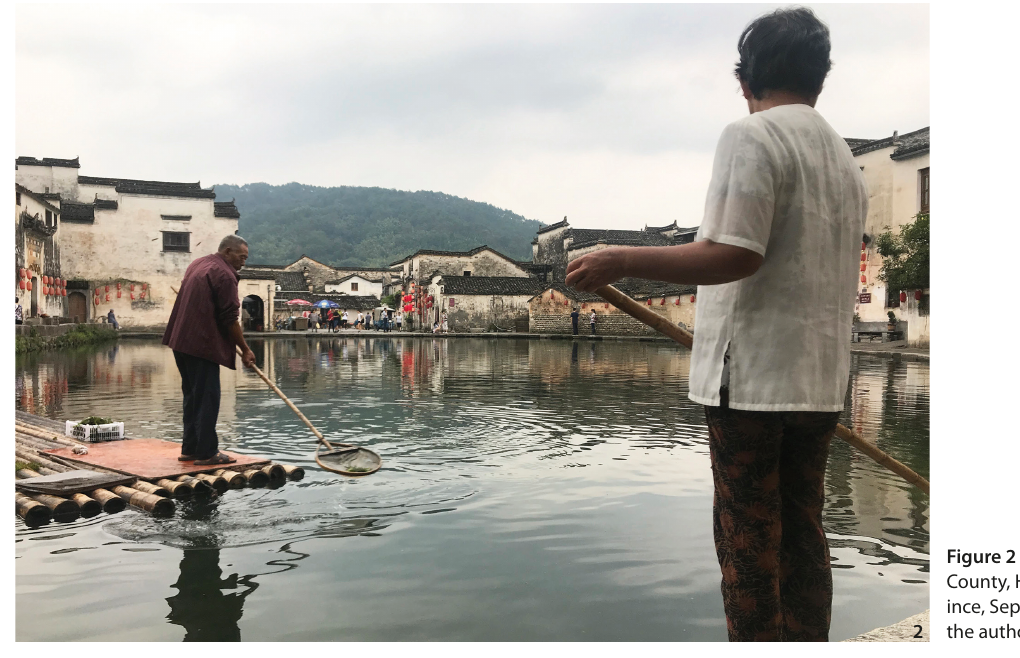
Figure 2 Hongcun Village, Yi County, Huangshan, Anhui